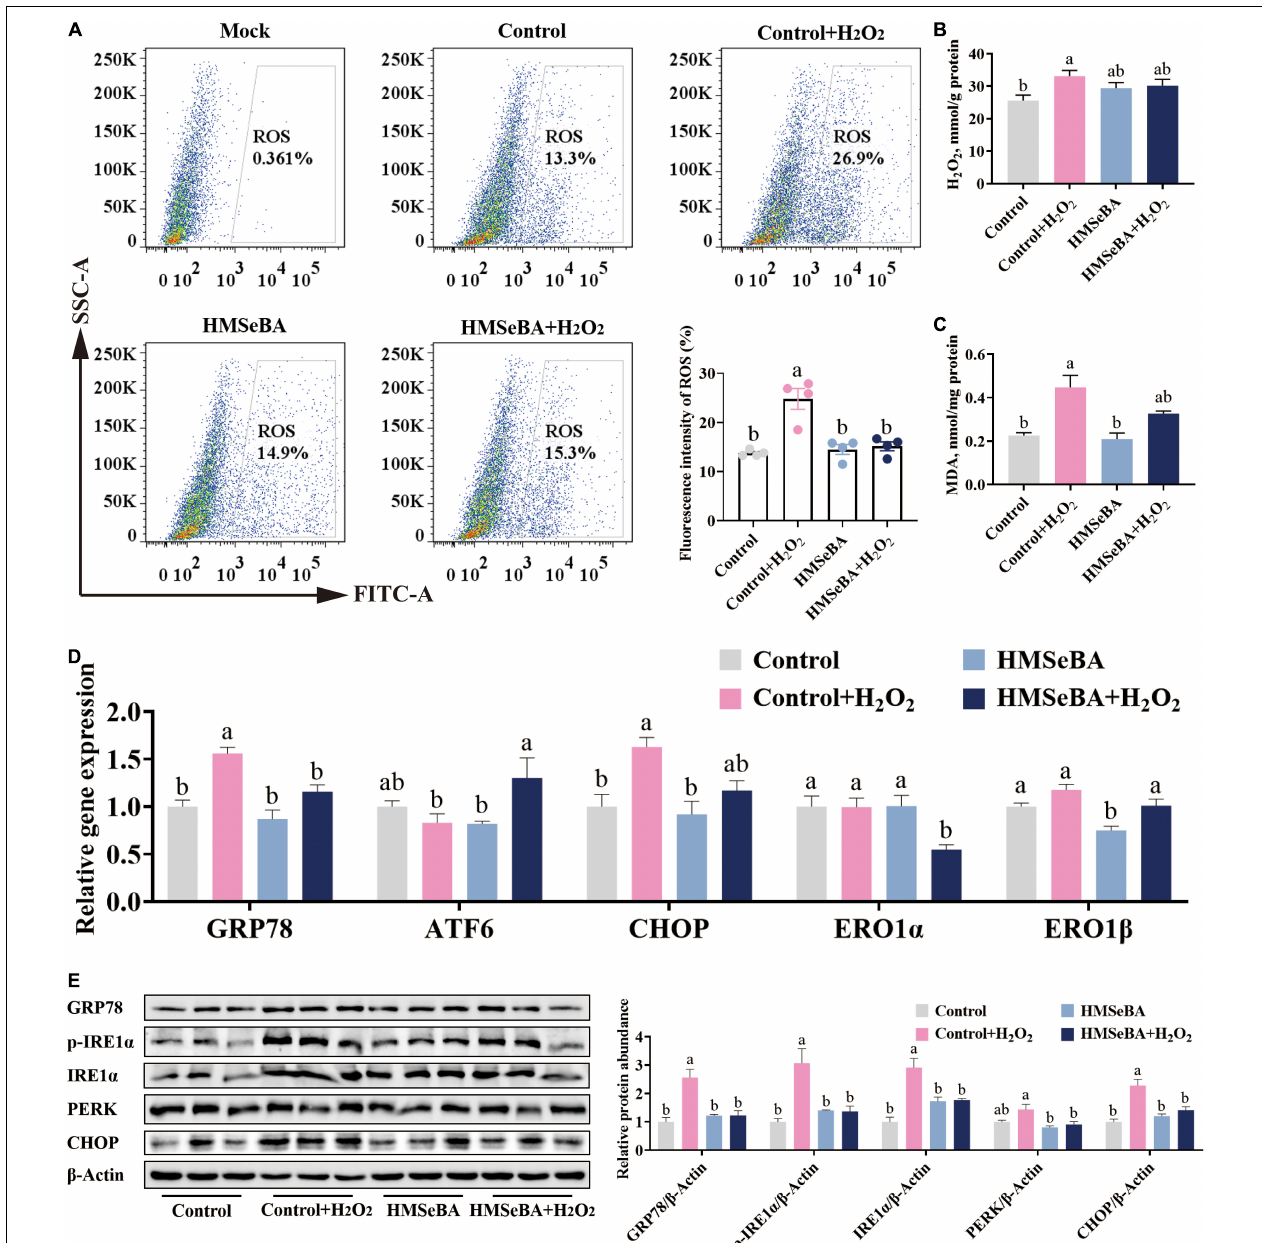
FIGURE 4 | Effect of HMSeBA on hydrogen peroxide induced oxidative status and ER stress in IPEC-J2 cells. IPEC-J2 cells were pretreated with HMSeBA for 24 h, then co-treatment with H 2 O 2 for 2 h. (A) ROS levels in IPEC-J2 cells. n = 4 for each group. (B,C) H 2 O 2 and MDA levels in IPEC-J2 cells. n = 6 for each group. (D) Relative gene expression of ER stress related markers in IPEC-J2 cells. n = 4 for each group. (E) Protein levels of ER stress related markers in IPEC-J2 cells. n = 3 for each group. Mock, as a blank control; H 2 O 2 , hydrogen peroxide; MDA, malondialdehyde. Data are expressed as mean ± SE. a,b Values with different superscript letters for same genes were significantly different ( P <